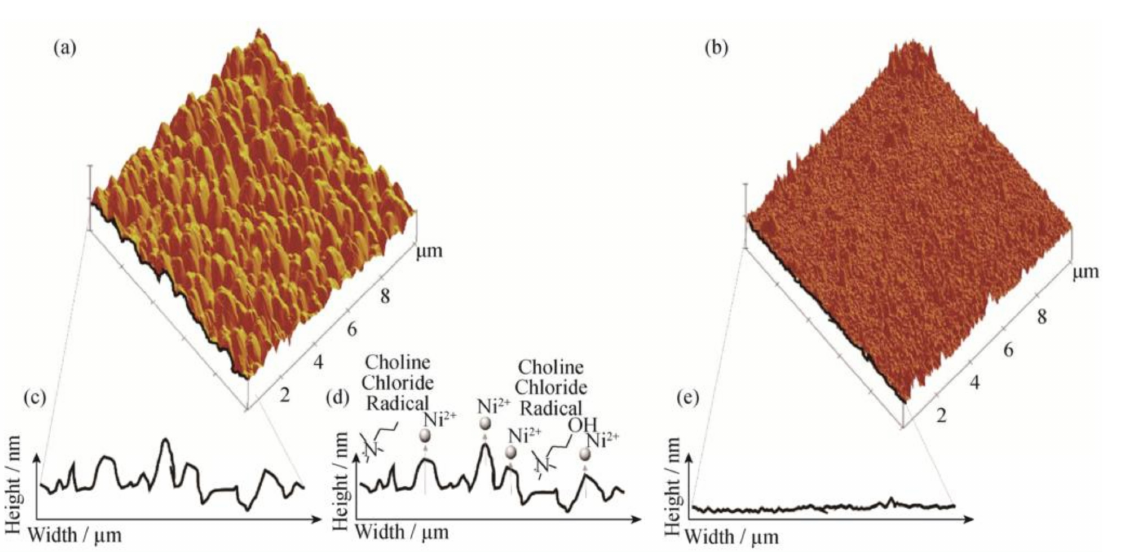
Figure 14. Schematic explanation of anodic leveling of nickel via AFM before electropolishing ( a ), and after electropolishing treatments ( b ), with representative 2D surface profiles depicted before the experiment ( c ), during the experiment ( d ), and after treatments ( e ). Vertical height scales are the same across all micrographs and profiles (reprinted with permission from ref. [62]; Copyright © 2019, University of Science and Technology Beijing and Springer-Verlag GmbH Germany, part of Springer